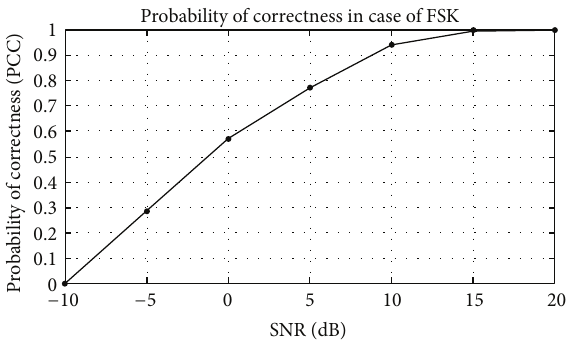
Figure 13: Probability of correctness (PCC) versus SNR for fixed number of iterations in FSK16 example.